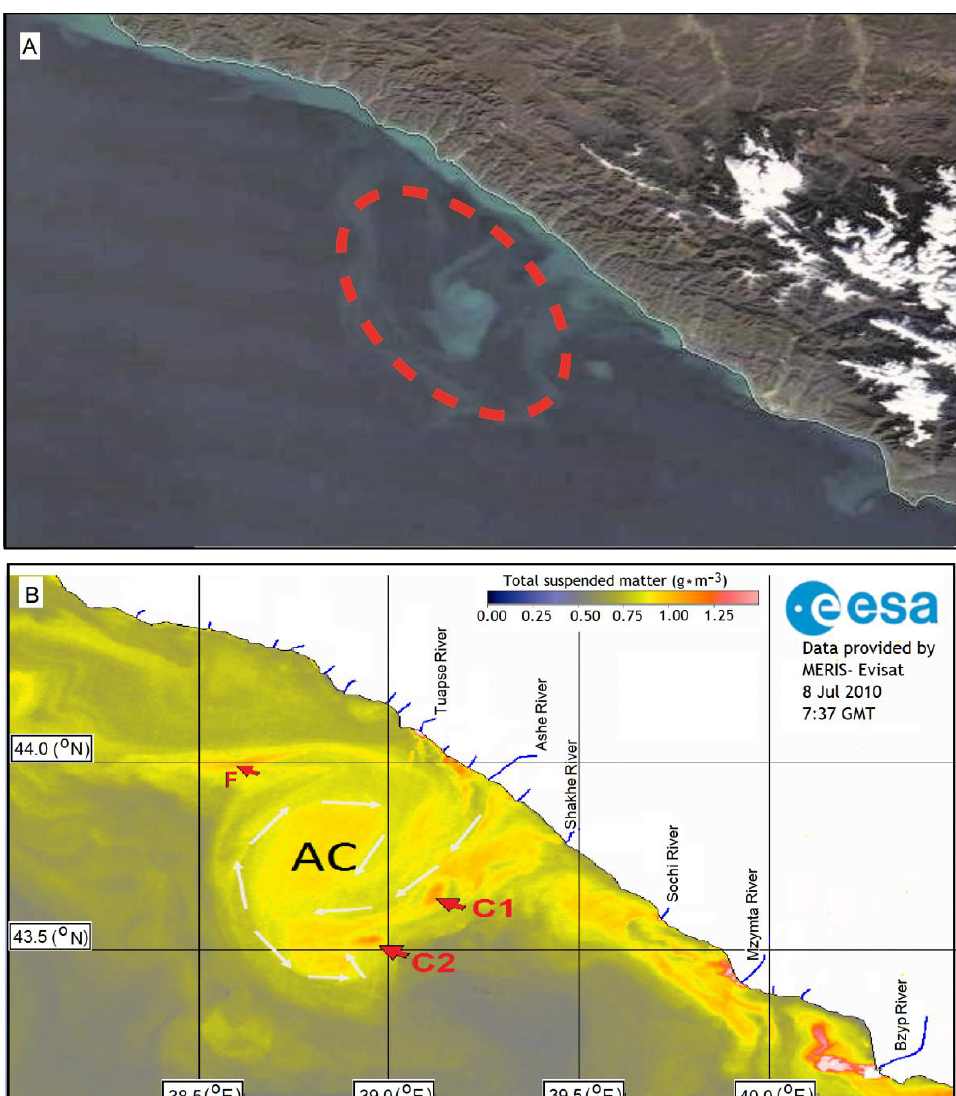
Figure 7. MODIS Aqua optical satellite image snapshot ( A ); and MERIS Envisat total suspended matter product ( B ) illustrating entrainment of river plumes by isolated eddies at the study area on 7 December 2021 and 8 July 2010, respectively.